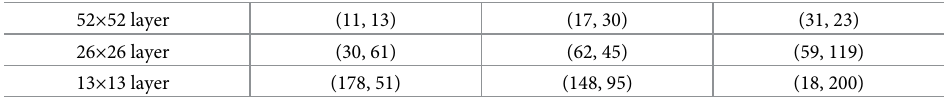
Table 1. Assignment of nine new bounding boxes by